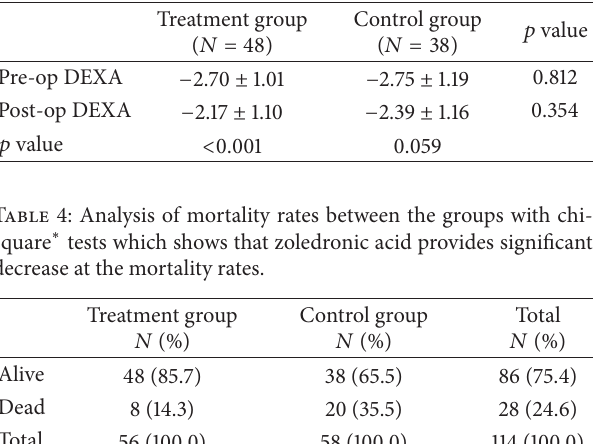
Table 3: Intergroup and intragroup paired 𝑡 -test for changes in 𝑇 scores which shows that zoledronic acid provides significant increase at the bone mineral density.